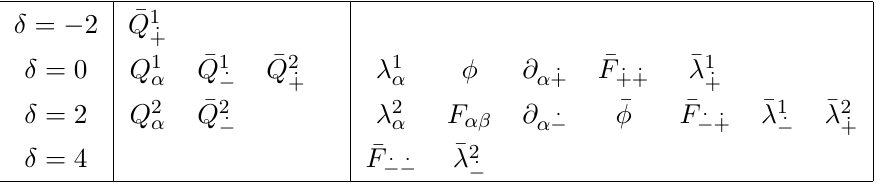
Table 1 . δ quantum numbers of the N = 2 Poincaré supercharges and fields in the free vector multiplet, ¯ D ⊕ D 0(0 , 0) 0(0 , 0)